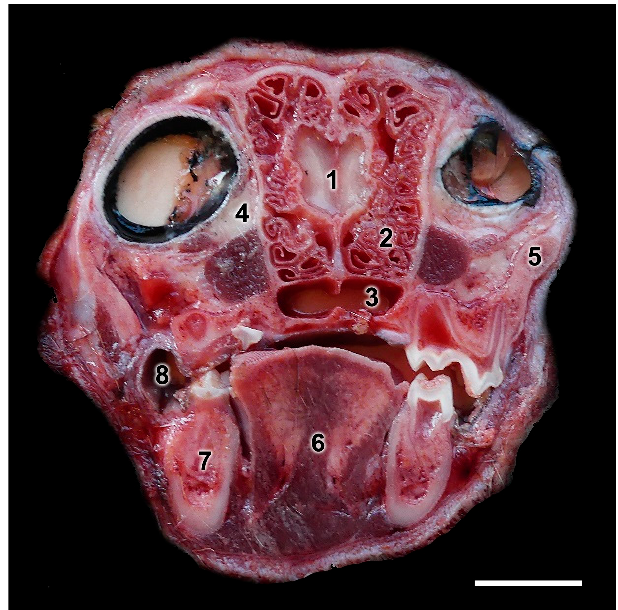
Figure 16. Transverse macroscopic section of the head of the fox at the level of the olfactory bulb (OB) showing its main topographic relationships. (1) Olfactory bulb; (2) Ethmoidal concha; (3) Choanas; (4) Zygomatic gland; (5) Zygomatic arch; (6) Tongue; (7) Mandible; (8) Buccolingual recess. Scale bar: 2 cm.